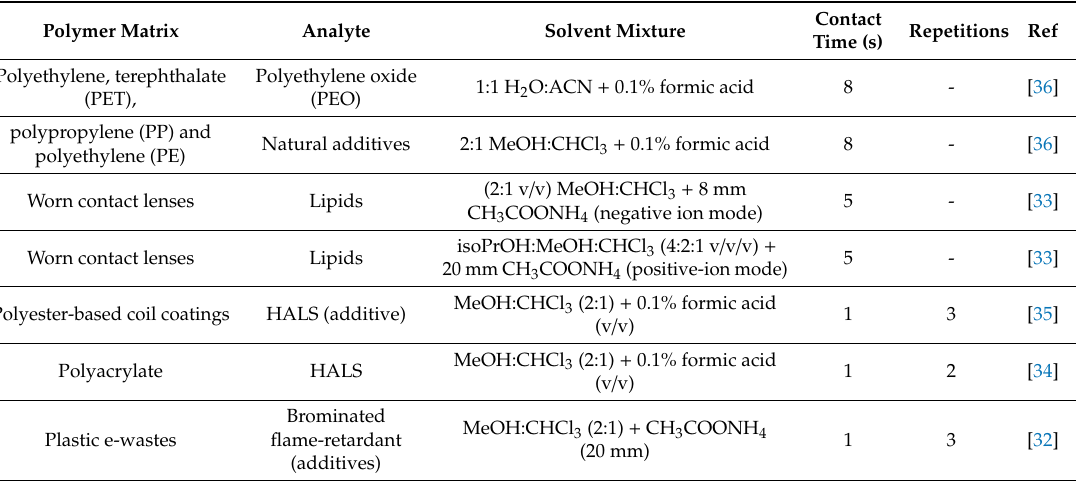
Table 1. LESA-MS parameters used for polymer analyses.